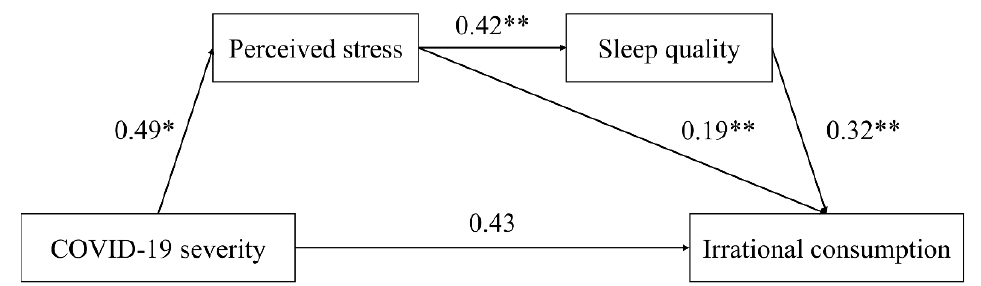
Figure 3. Mediation analysis: perceived stress and sleep quality as mediators (Study 1, higher scores of sleep quality scale indicates worse the sleep quality). * represents significance at the 0.05 level; ** represents significance at the 0.01 level.